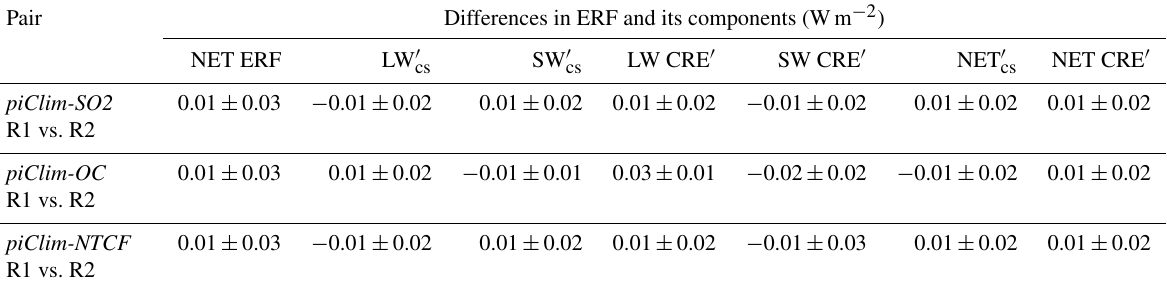
Table 4. Differences in the present-day ERF and its components between two realizations (R1 and R2) of the same perturbation experiment relative to piClim-control . Units in Wm − 2